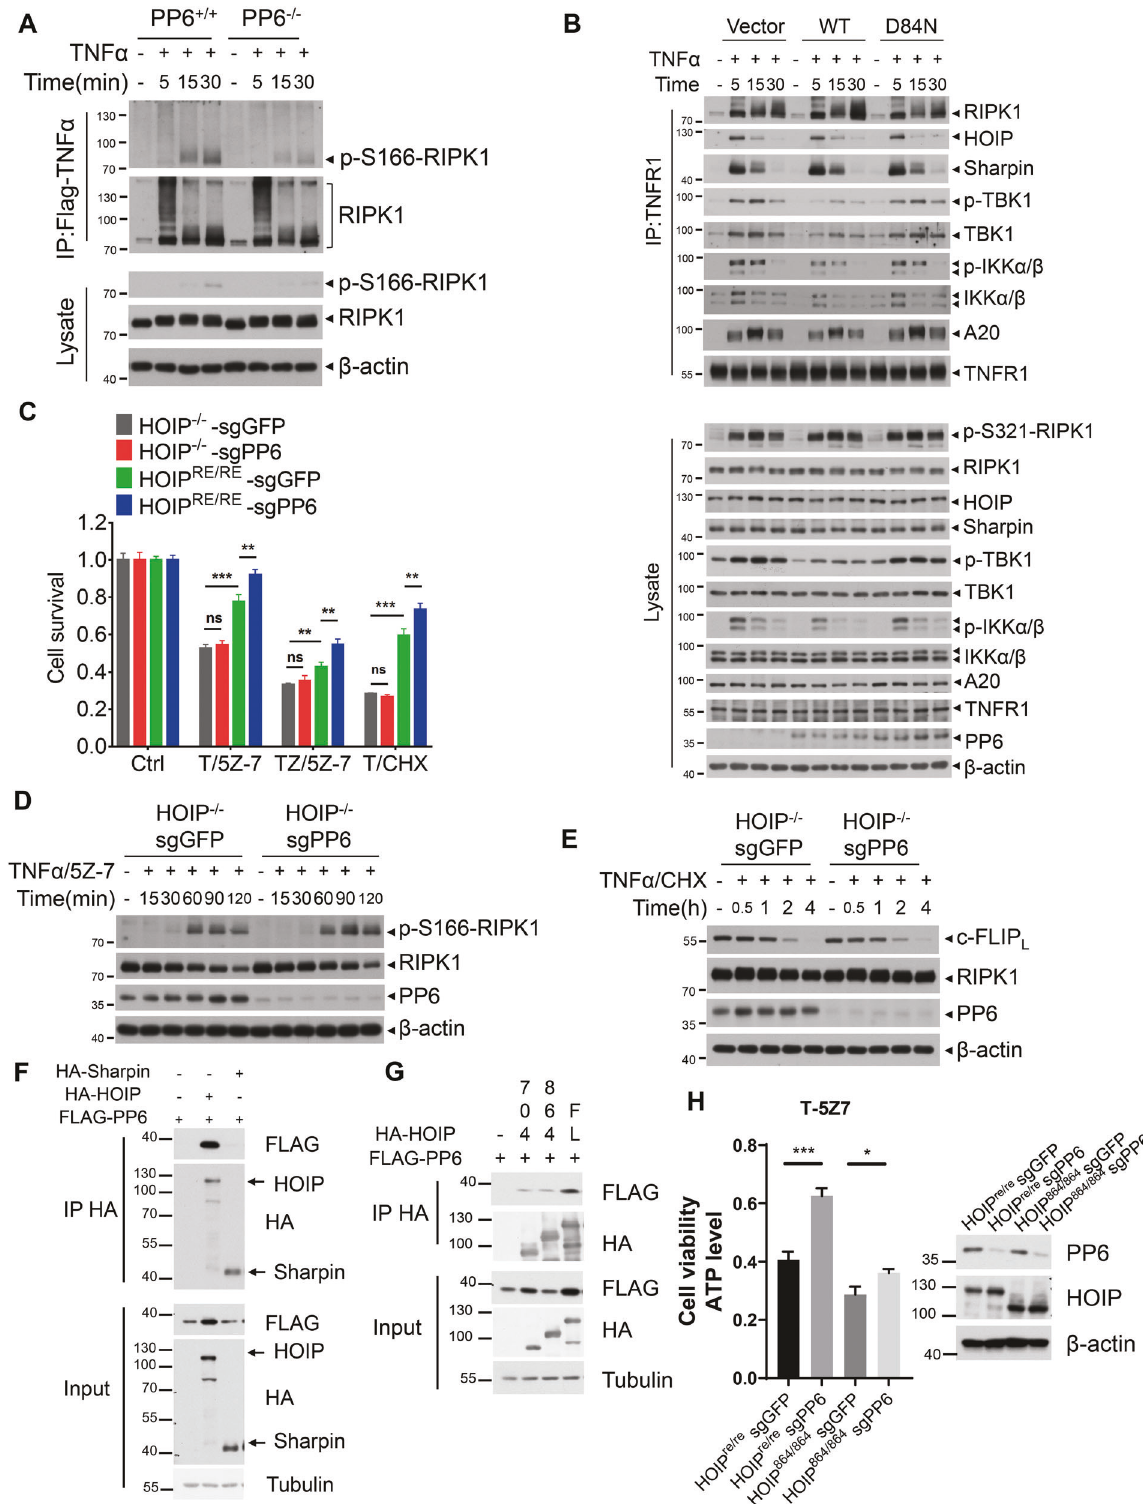
melanoma-associated PP6 mutations were known to lead to reduction or loss of the phosphatase activity [54]. We found that knockout of PP6 in various cancer cell lines including B16-F10 melanoma cells reduced the sensitivity to TNF α (Fig. 7A). Since our Cell Death and Disease (2022)